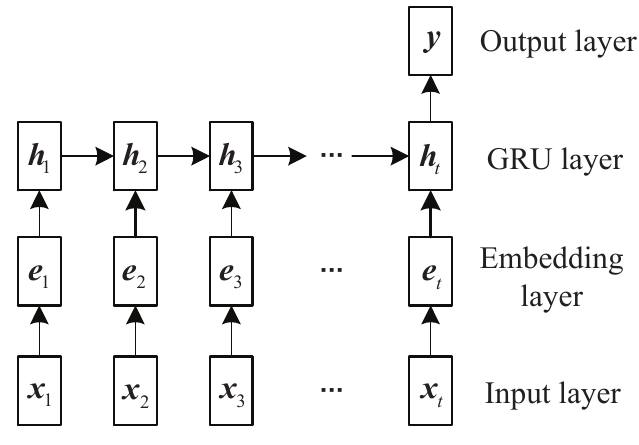
Figure 4. The network architecture of radar word